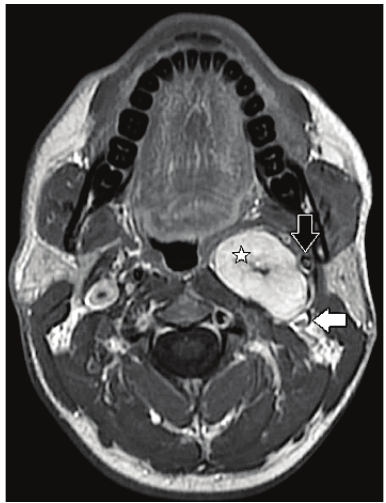
Figure 1: Patient 1 T1-weighted enhanced MRI scan: encapsulated tumor of the left retrostyloid compartment, 5 cm by 4 cm in size (white star). The internal carotid artery (black arrow) is displaced anterolaterally; the internal jugular vein is displaced posteriorly (horizontal white arrow).